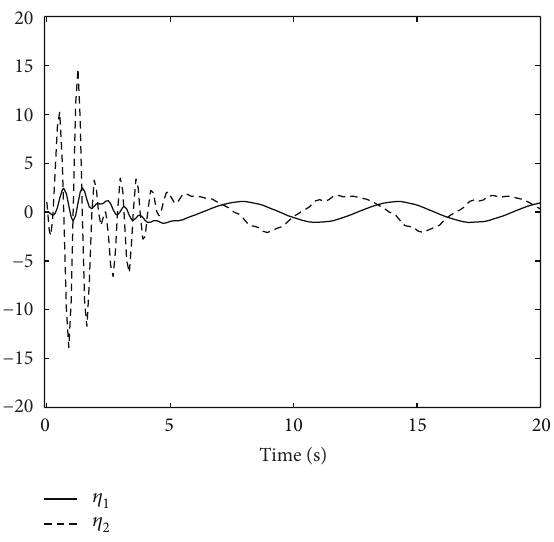
Figure 2: The trajectories of the system states 𝜂 1 and 𝜂 2